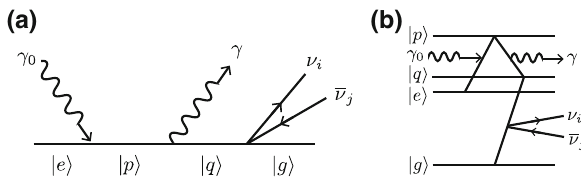
Fig. 1 a Feynman diagram of γ 0 + | e (cid:2) → γ + | g (cid:2) + ν i ¯ ν j . There are five more diagrams that contribute off resonances, as in Eq. (3). b Corresponding energy levels indicating absorption and emission of photons and a neutrino-pair